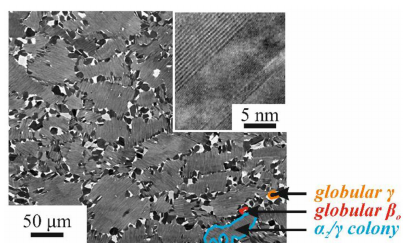
Figure 1. Nearly lamellar microstructure of a nominal TNM alloy (SEM-back-scatter electron (BSE) image) The microstructure, which was arranged during a two-step heat treatment, consists of lamellar α 2 / γ colonies surrounded by globular γ and β o grains (dark and bright contrast, respectively). The insert (HRTEM image) features a lamellar colony. (Reproduced with